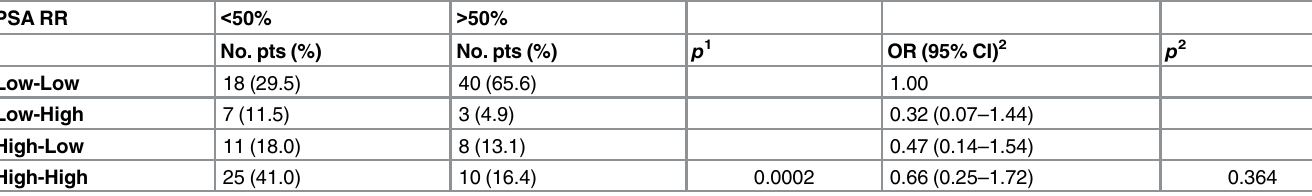
Table 1. Changes in NLR and PSA response rate at